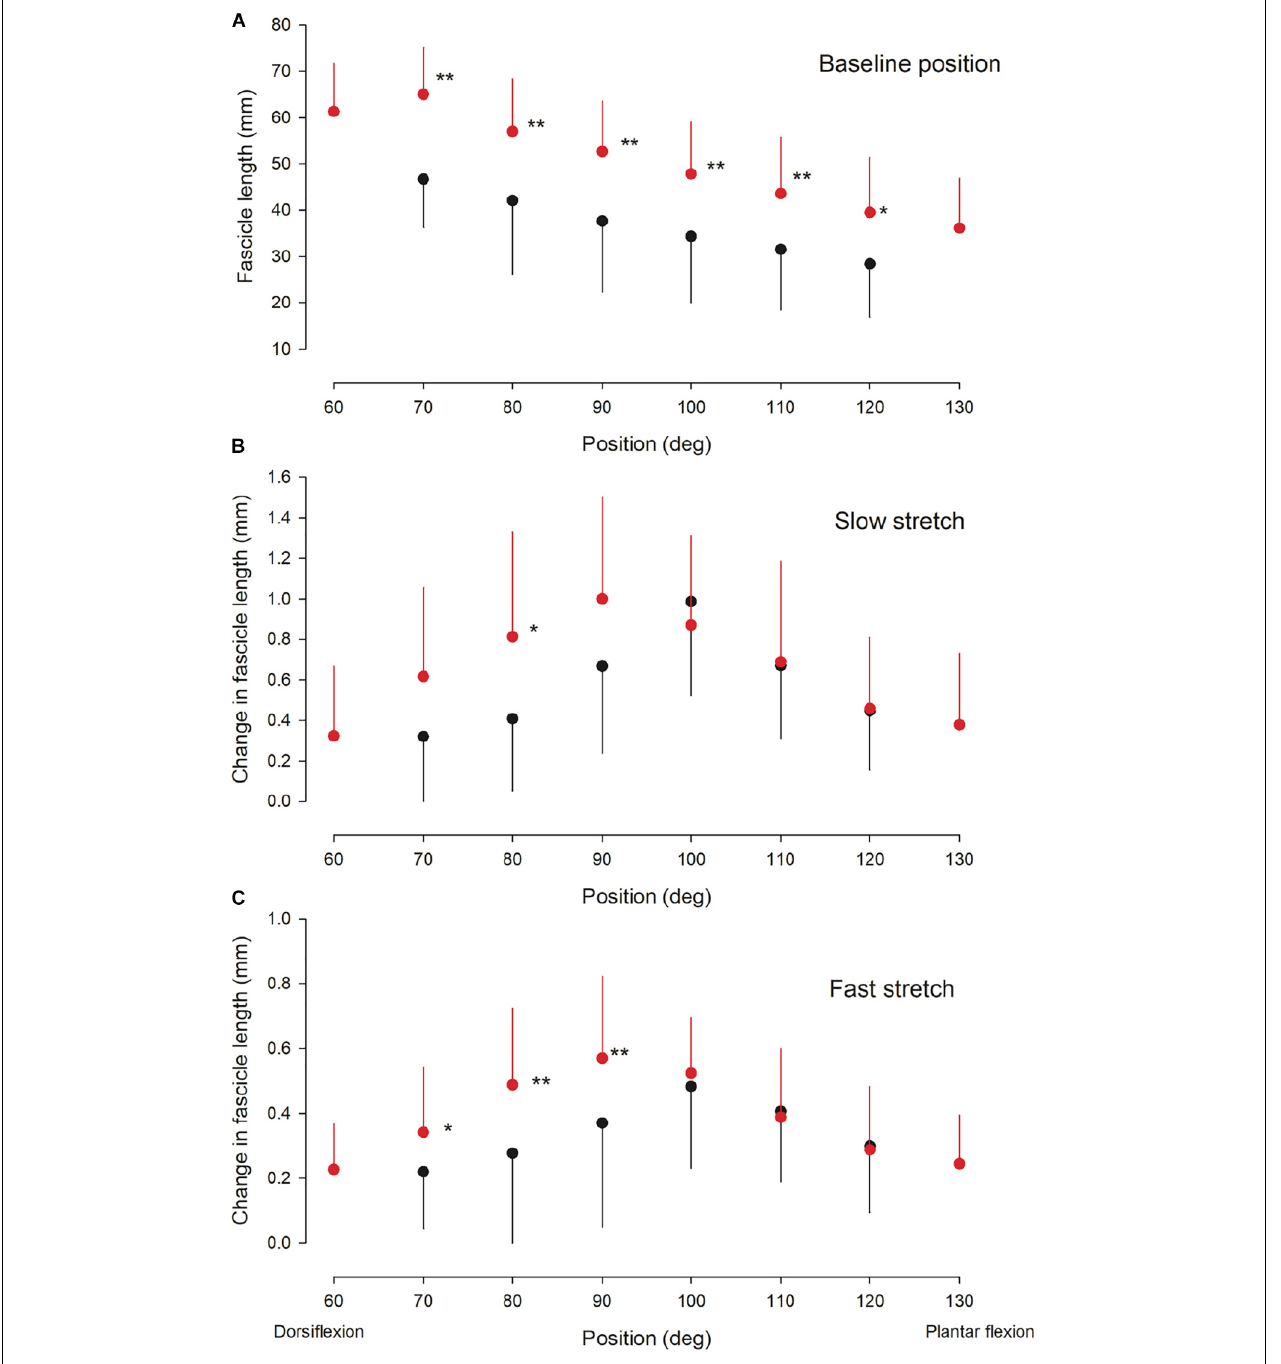
FIGURE 3 | Ultrasound findings. Medial gastrocnemius fascicle length at baseline (rest) (A) and the change in medial gastrocnemius muscle fascicle length elicited by a slow (B) and fast (C) stretch of the ankle plantarflexor muscle-tendon unit at different ankle joint positions throughout the range of movement in the NI (red circles) and CP group (black circles). Otherwise similar legend as for Figure 2 . Statistically significant differences in measurements between the two groups are indicated by stars. * p < 0.05, ** p < 0.01.